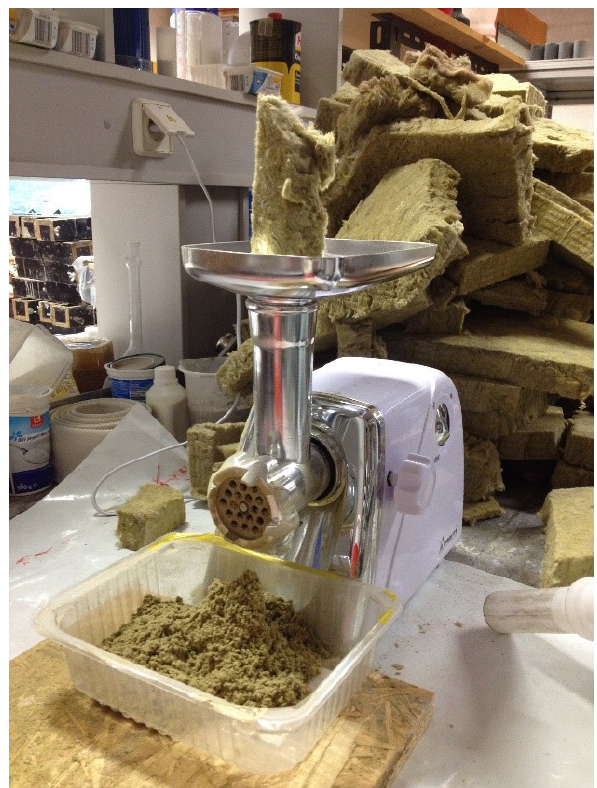
Figure 2: Photograph of basalt fibre grounded using the